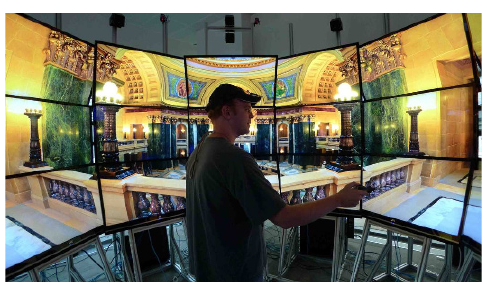
Figure 12. KAUST’s NexCAVE showing a stereo 360 o scan of the Wisconsin State Capitol (in mono mode). Content: Dick Ainsworth. Photo: Tom DeFanti.